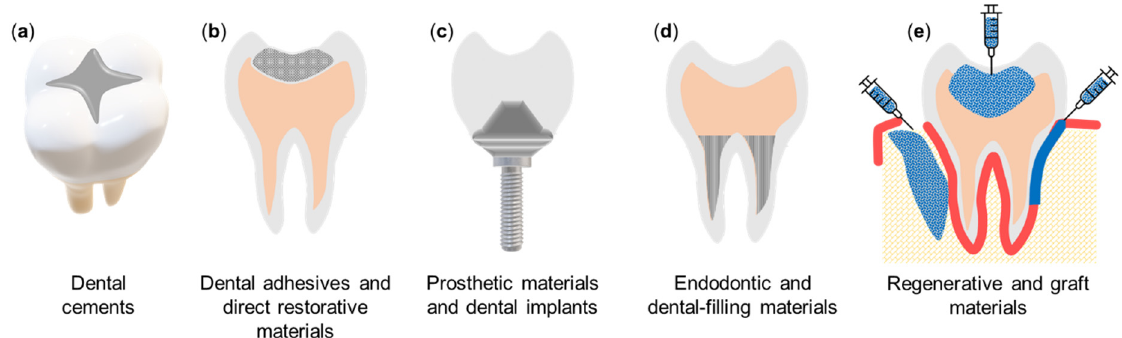
Figure 2. Illustrations of dental material applications that require antimicrobial and antifouling properties: ( a ) dental cements; ( b ) dental adhesives and direct restorative materials; ( c ) prosthetic materials and dental implants; ( d ) endodontic and dental-filling materials; ( e ) regenerative and graft materials.